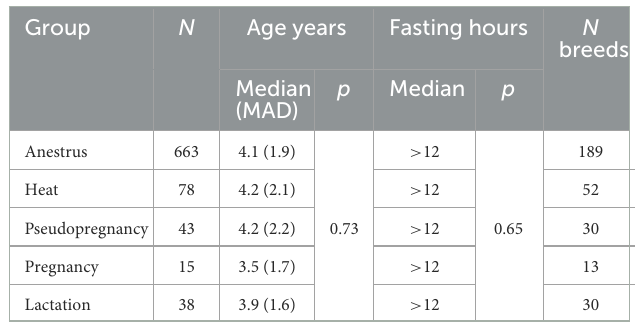
TABLE 1 Characteristics of the study